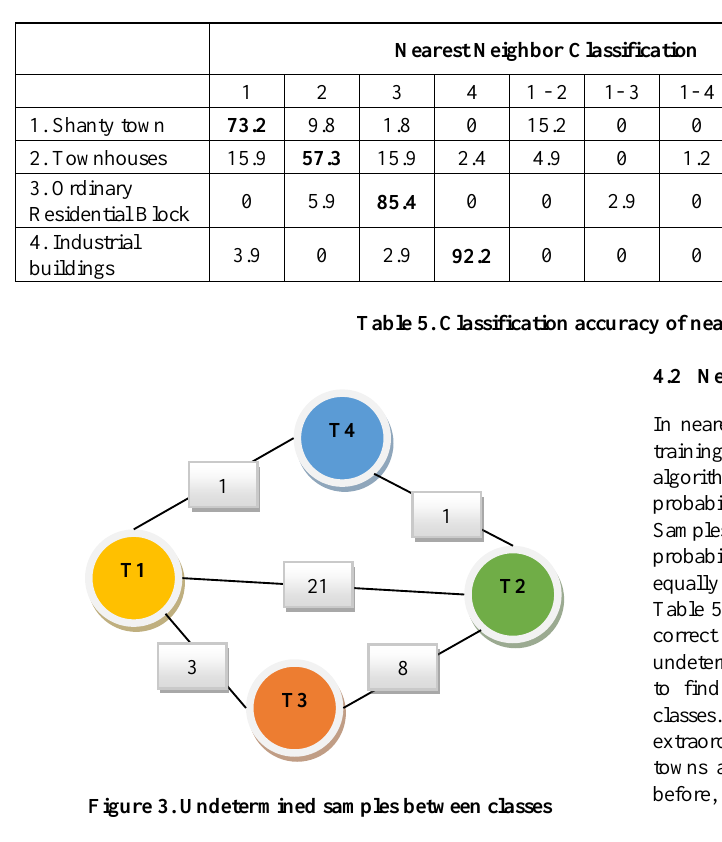
Figure 3. Undetermined samples between classes